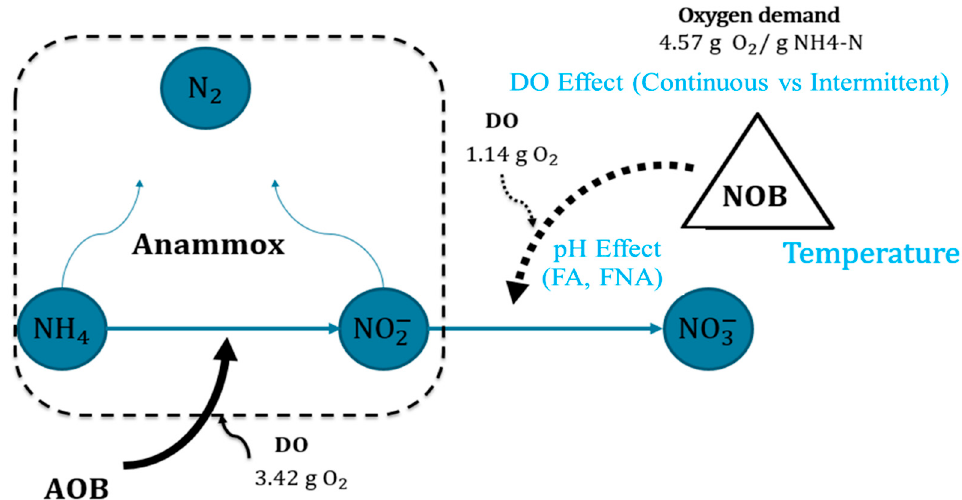
Figure 3. An overview of the role of influencing factor on nitrogen removal process. 3.42 g O 2 —oxygen demand for ammonium oxidation to nitrite; 1.14 g O 2 —oxygen demand for nitrite oxidation to nitrate; 4.57 g O 2 —total oxygen demand for ammonium oxidation to nitrate [45].